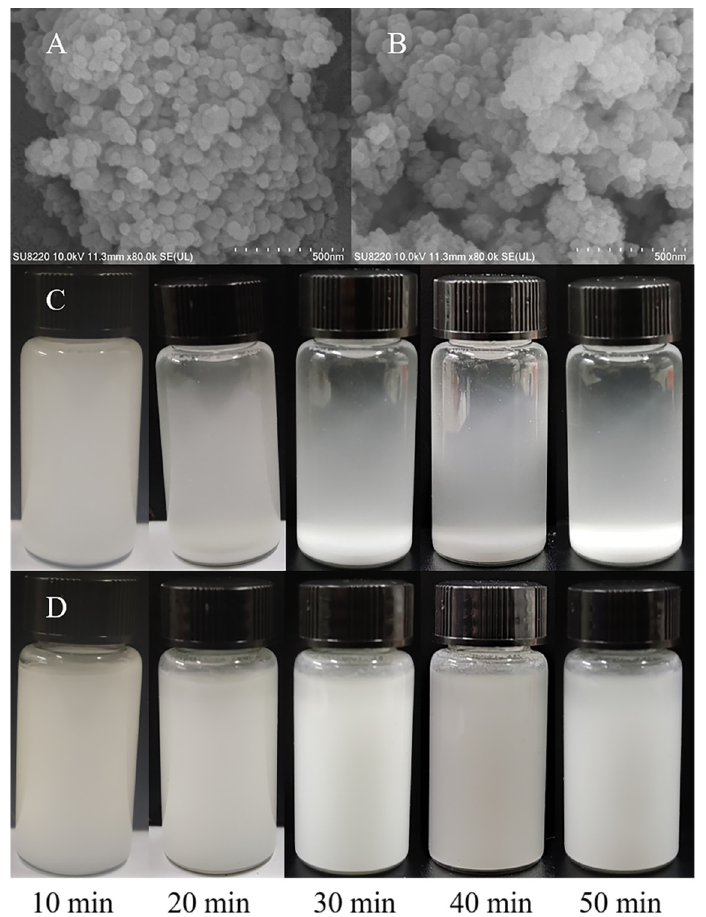
Figure 5. SEM images of nano-CaCO 3 ( A ) and MNC ( B ), and the dispersion of nano-CaCO 3 ( C ) and MNC ( D ) in aqueous solution.